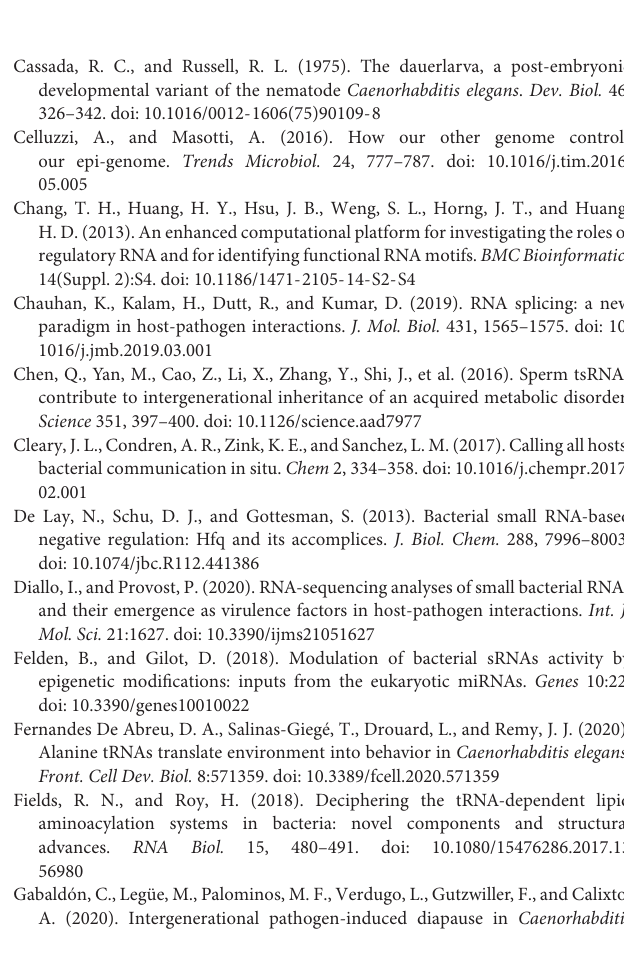
Supplementary Figure 2 | Venn diagram showing shared putative C. elegans targets of sRNAs microRNA-sized that are induced and expressed in C. elegans intestines from P. aeruginosa . Supplementary Table 1 | Caenorhabditis elegans genomic annotations mapped by naïve P. aeruginosa PAO1 reads. List of C. elegans genes mapped by P. aeruginosa reads expressed in host-naïve conditions.